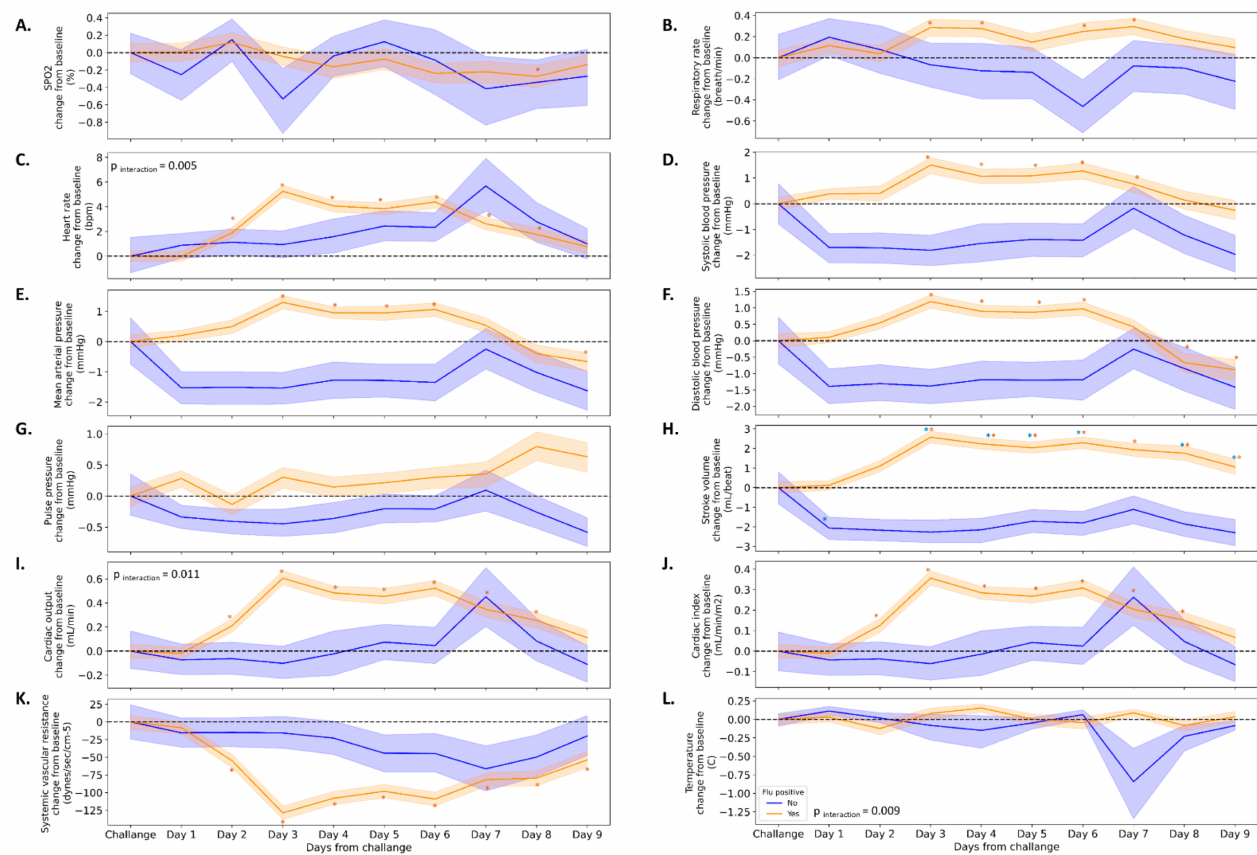
Figure 4. Changes in physiological parameters following exposure among participants in which virus was detected and among participants in which virus was not detected. Relative changes from baseline in physiological parameters ( A – L ) among participants in which virus was detected (blue lines) or not detected (orange lines). Dashed line represents the baseline. The interaction was assessed using mixed-model ANOVA. * Value significantly ( p < 0.05) different from